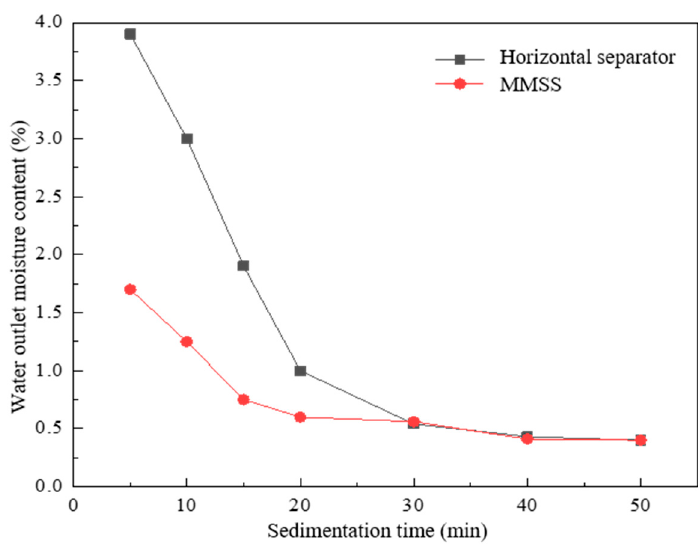
Figure 12. Change in oil content of the water outlet with settlement time.